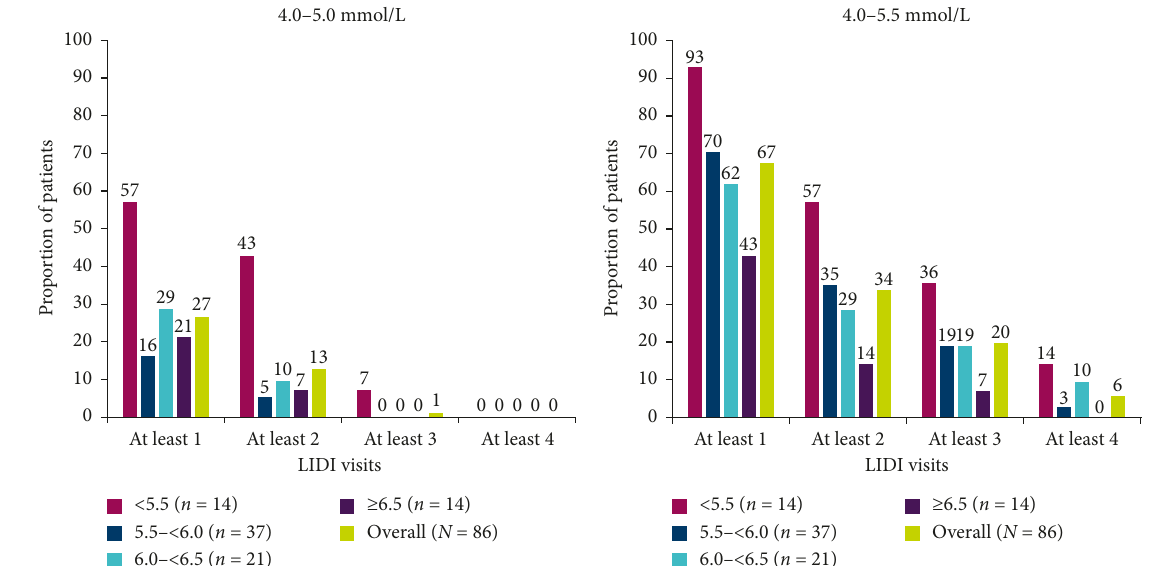
Figure 3: Proportion of placebo patients with predialysis sK + ranges of 4.0–5.0 and 4.0–5.5 mmol/L for the 4-week evaluation period, by predialysis sK + concentration at randomization. Predialysis sK + measurement at randomization (visit 4, day 1) was used for subgroup stratification. Predialysis sK + values obtained at the LIDI visits in the 4-week evaluation period. No imputation of missing data was conducted. Patients receiving rescue therapy were included in the analysis. LIDI, long interdialytic interval; sK + , serum